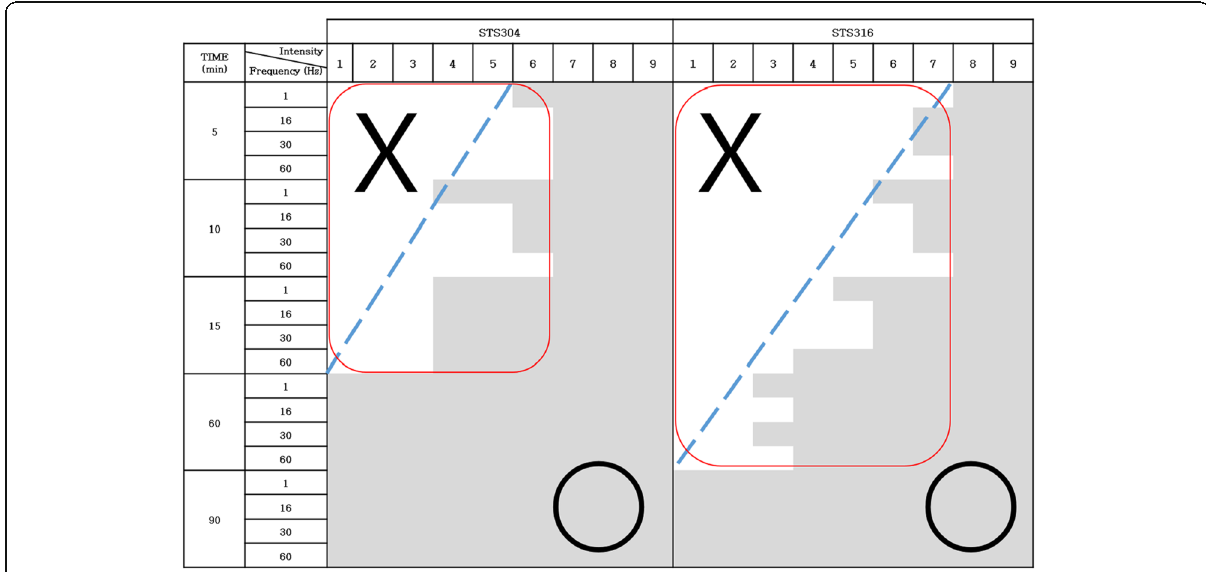
Fig. 3 Comparison of corrosion in STS304 and STS316 according to electrical stimulation intensity, frequency, and time. The sections shaded gray indicate corrosion ( ○ ), and the section in white indicates no corrosion (X). No corrosion was observed in STS304 under any conditions with an intensity less than 3 and a duration less than 10min, and no corrosion was observed in STS316 under any conditions with an intensity below 4 and a duration less than 15 min (except 60Hz for 15min). Based on the results above, STS316 is more resistant than STS304 to corrosion after the application of electrical